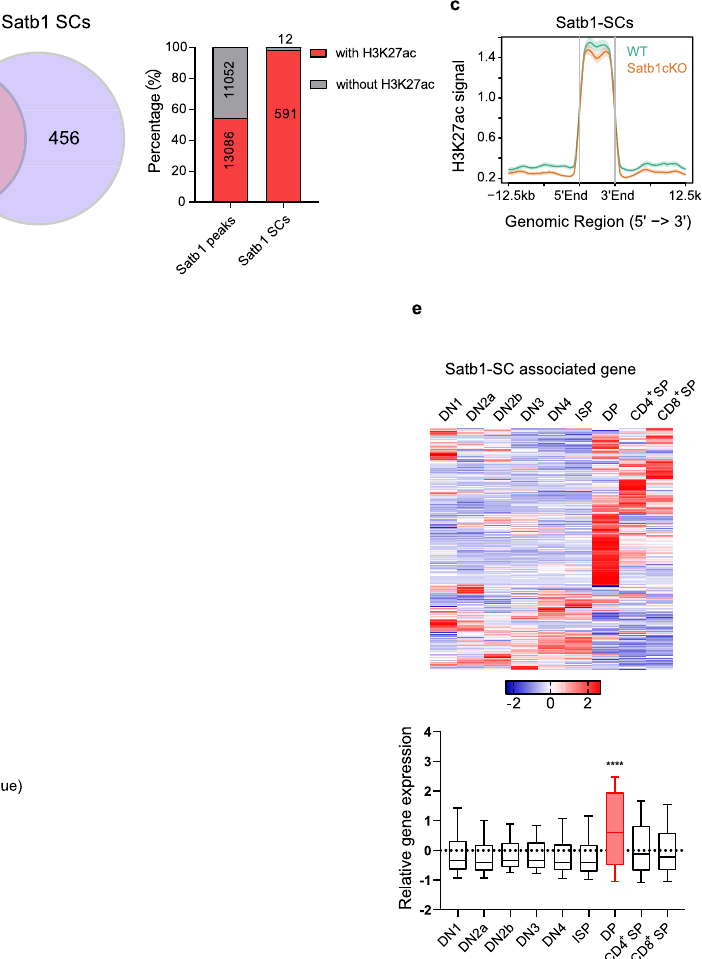
no adjustment since only one geneset was tested. e Heatmap (up) and boxplot (bottom) showing relative gene expressions of SATB1 super-culster-associated genes (795 genes) during the differentiation from DN1 to SP thymocytes. P value between DP and other stages as following; DN1, 6.50e-30; DN2a, 2.92e-41; DN2b, 5.23e-24; DN3, 1.32e-26; DN4, 1.08e-38; ISP, 4.00e-42; CD4SP, 2.97e-15; CD8SP, 1.85e-19.DetailsofdatacanbefoundinSupplementaryDataS6.**** P value<0.0001 by Kruskal – Wallis test, followed by Dunn ’ s multiple comparisons test. f Gene ontology analysison the genes associatedwithsuper-enhancersby enrichment for H3K27ac or super-clusters of Satb1. The top seven biological processes ranked by signi fi cance ( − log(q-value)) are depicted. Source data are provided as a Source Data fi